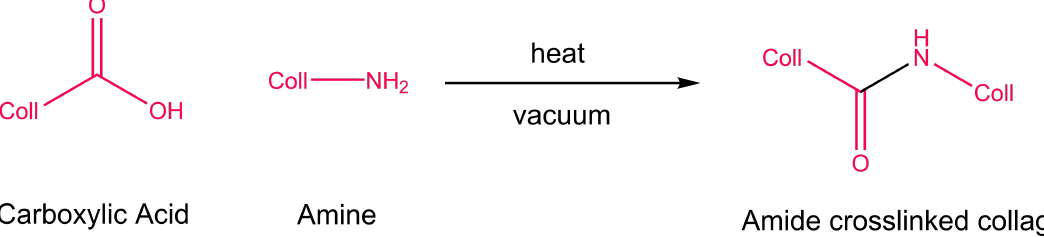
Figure 4. Dehydrothermal mechanism of crosslinking. Illustration redrawn from mechanisms by Haugh et al.